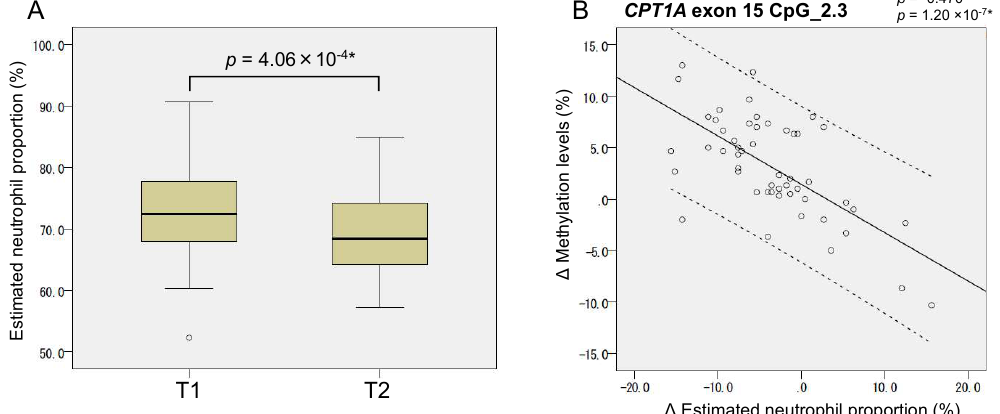
Figure 4. ( A ) Estimated neutrophil proportions at two specific time points during pregnancy. Box and whisker plots illustrate medians, minimum values, maximum values, and interquartile ranges. ( B ) Association of CPT1A exon 15 methylation change and neutrophil proportion change from T1 to T2. β indicates methylation change (%) per unit (1%) increase in neutrophil proportion from T1 to T2. Solid, a regression line; dotted, 95% confidence intervals. Statistics were calculated using ( A ) paired t -testing and ( B ) regression analysis.